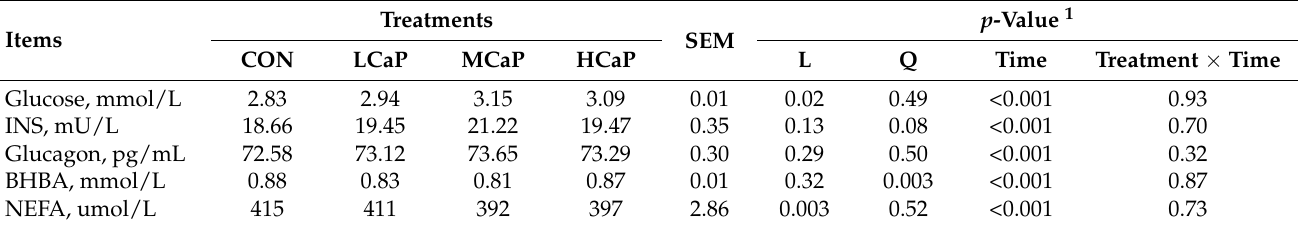
Table 2. Effects of supplementing calcium propionate on serum biochemical parameters related to NEB in dairy cows in early